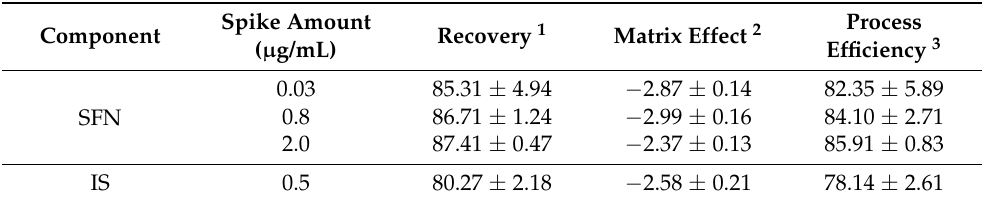
Table 3. Recovery, matrix effect, and process efficiency of SFN and the IS from spiked rat plasma ( n = 4).